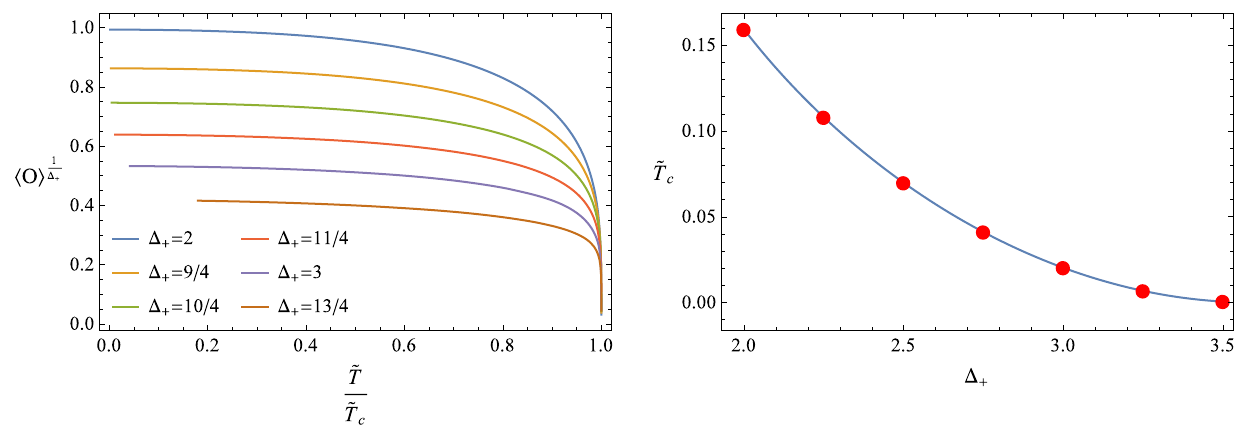
Fig. 2 Left: The condensate as a function of temperature (scaled by the corresponding critical temperature) for various values of (cid:16) + . The lowest curve corresponds to (cid:16) + = 13 and the top curve is for (cid:16) + = 2. Right: The critical temperature as a function of (cid:16) 4